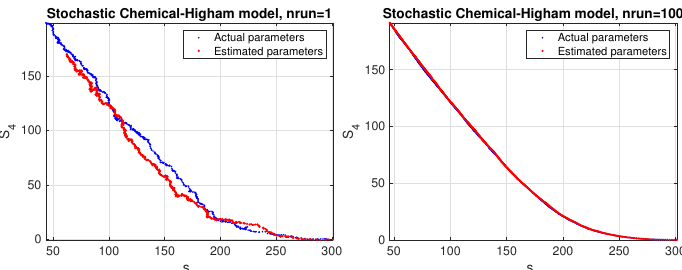
Figure 6. Phase space corresponding to a stochastic simulation of the Higham chemical model using the estimated parameters (red color) compared to the actual parameters (blue color). The results are shown for a single trial ( left panel ) and average over 100 trials ( right panel